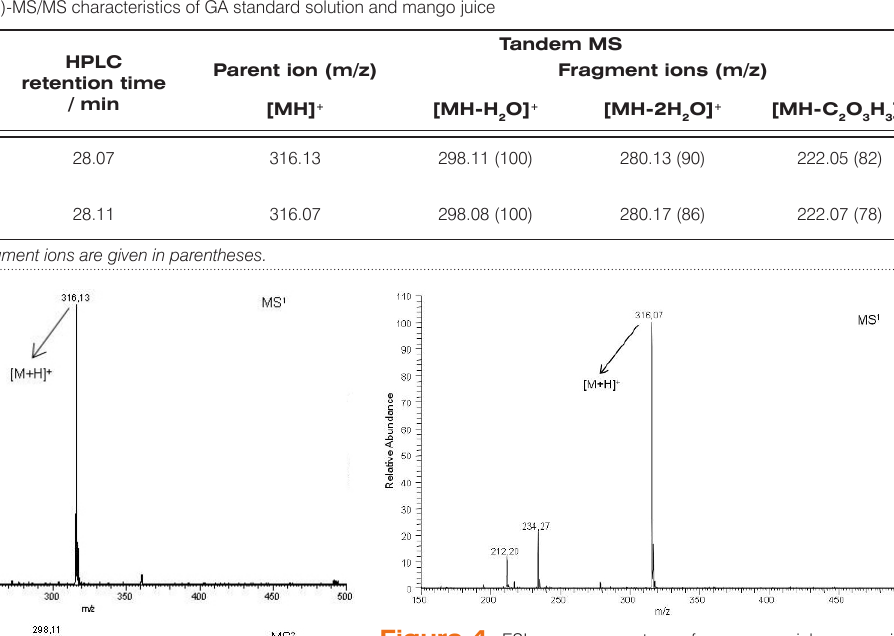
Figure 4. ESI mass spectrum for commercial mango juice ([M+H] + of m/z 316).